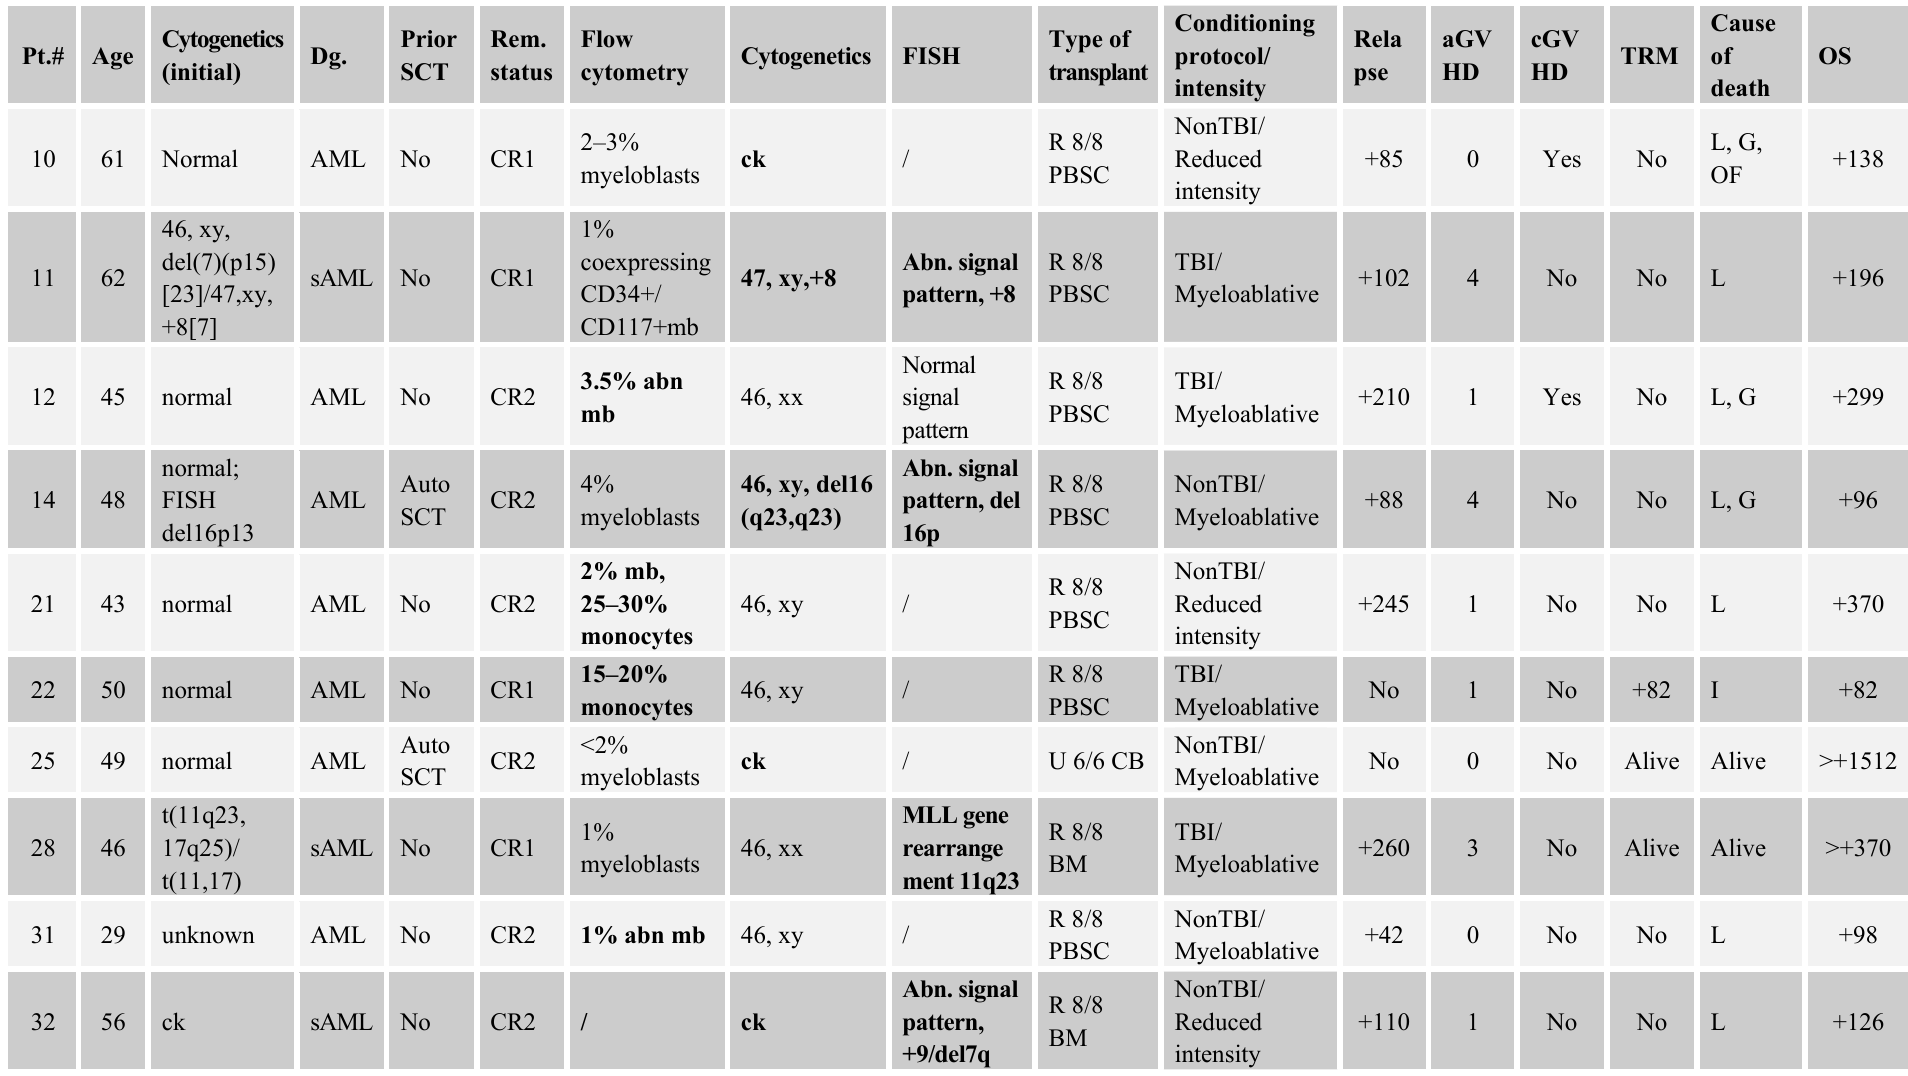
Table 2. Characteristics of MRD-positive